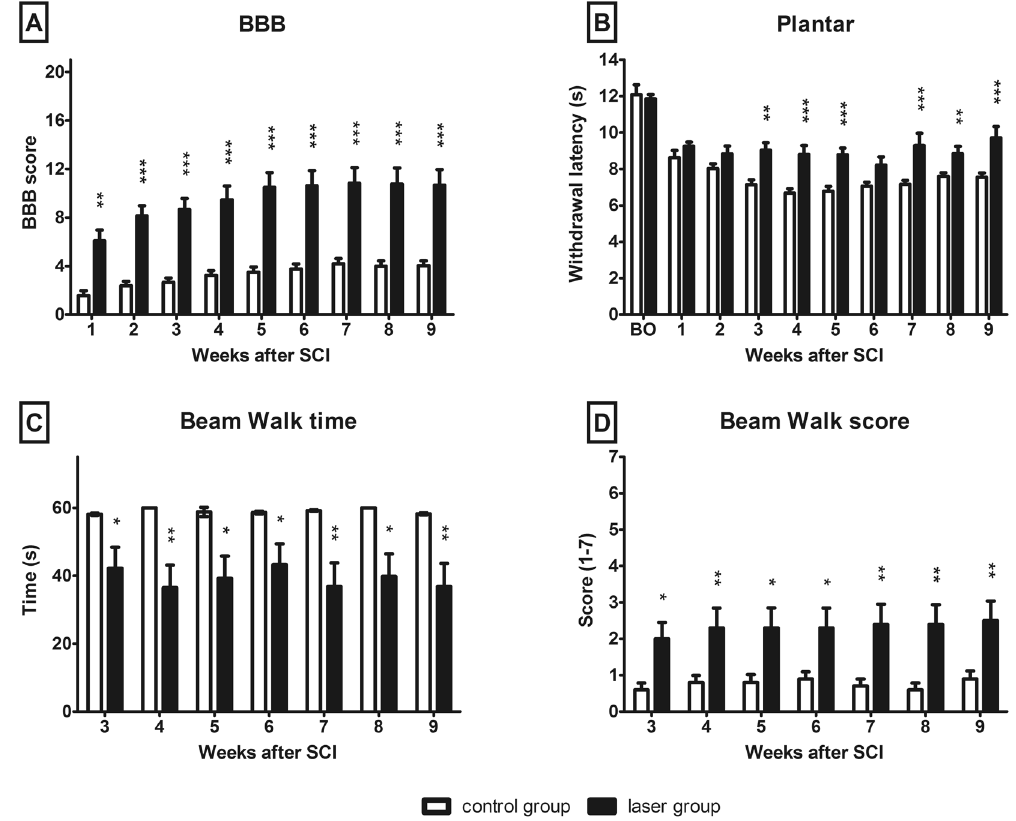
( B ) Plantar test for sensitivity to thermal stimulus. The hind paw withdrawal latencies of the laser-treated group were significantly higher compared to control animals and almost reached the pre-injury values. ( C , D ) Complex motor performance evaluated by beam walk test. Laser treated group showed better performance and needed less time to cross the beam. The values are expressed as mean ± SEM. Control group n = 11, laser- treated group n = 15. * p < 0.05, ** p < 0.01, *** p < 0.001. BO – before